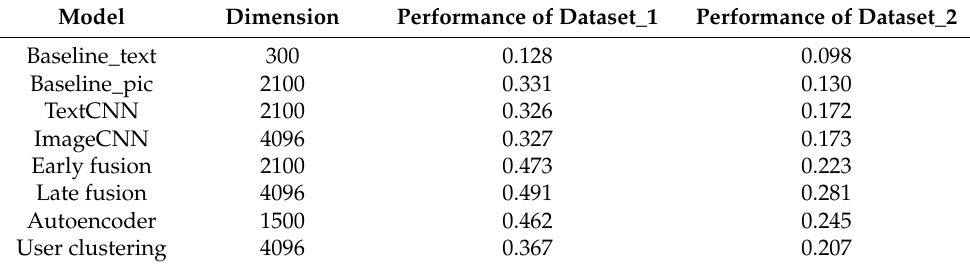
Table 3. The performance comparison of all experimental